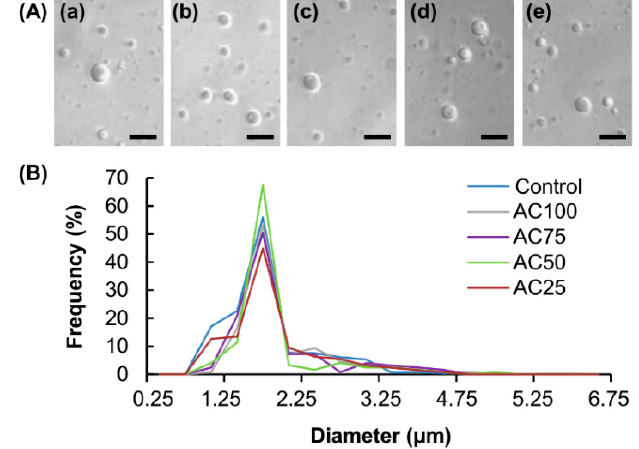
Figure 7. ( A ) Optical images of ( a ) freshly prepared blank vesicles and those released from ( b ) AC100, ( c ) AC75, ( d ) AC50 and ( e ) AC25. Scale bar = 10 µm. ( B ) The size distribution profiles of the blank vesicles upon being loaded into complex gels with different mass percentages of CMC-Na. Freshly prepared blank vesicles are adopted as the control.